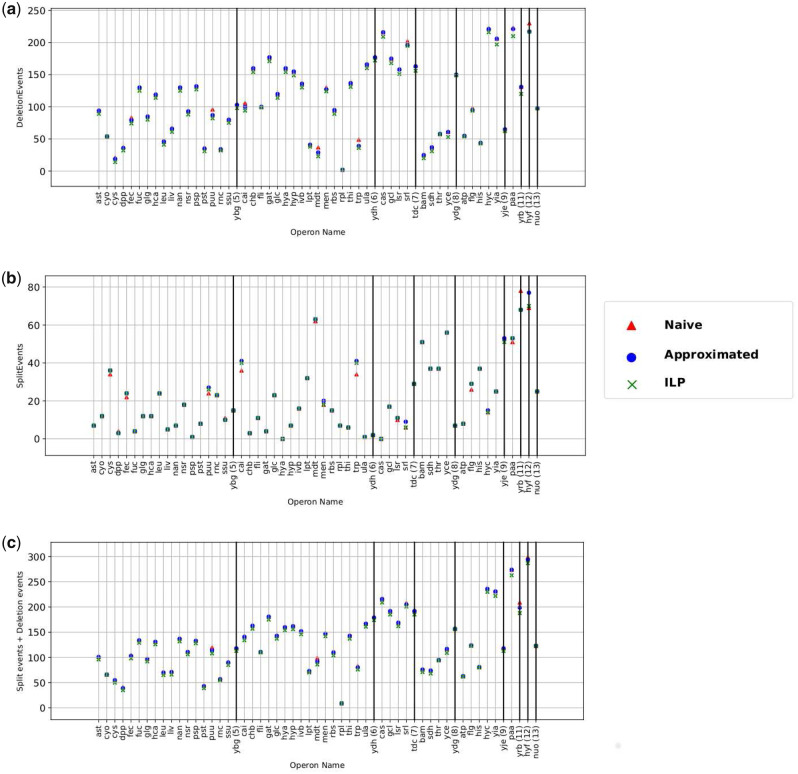
For X-axis values see Figure 2. The y-axis is the event count for the orthologous gene block in each species compare to the reference gene block. (a) Dots represents deletion events, (b) split events, (c) sum of deletion and split events